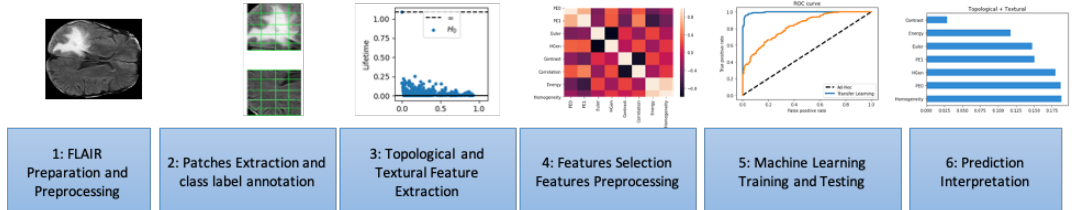
Figure 6. Flowchart depicting the main sequence of steps performed in the third experiment. The steps are documented in the text.